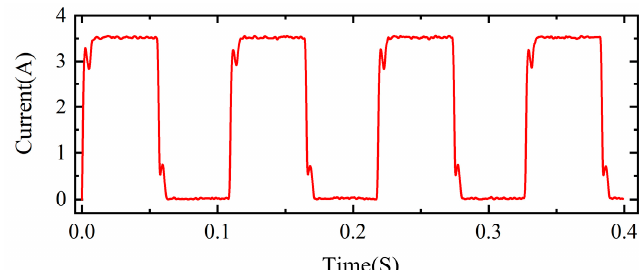
Figure 7. Current signal.